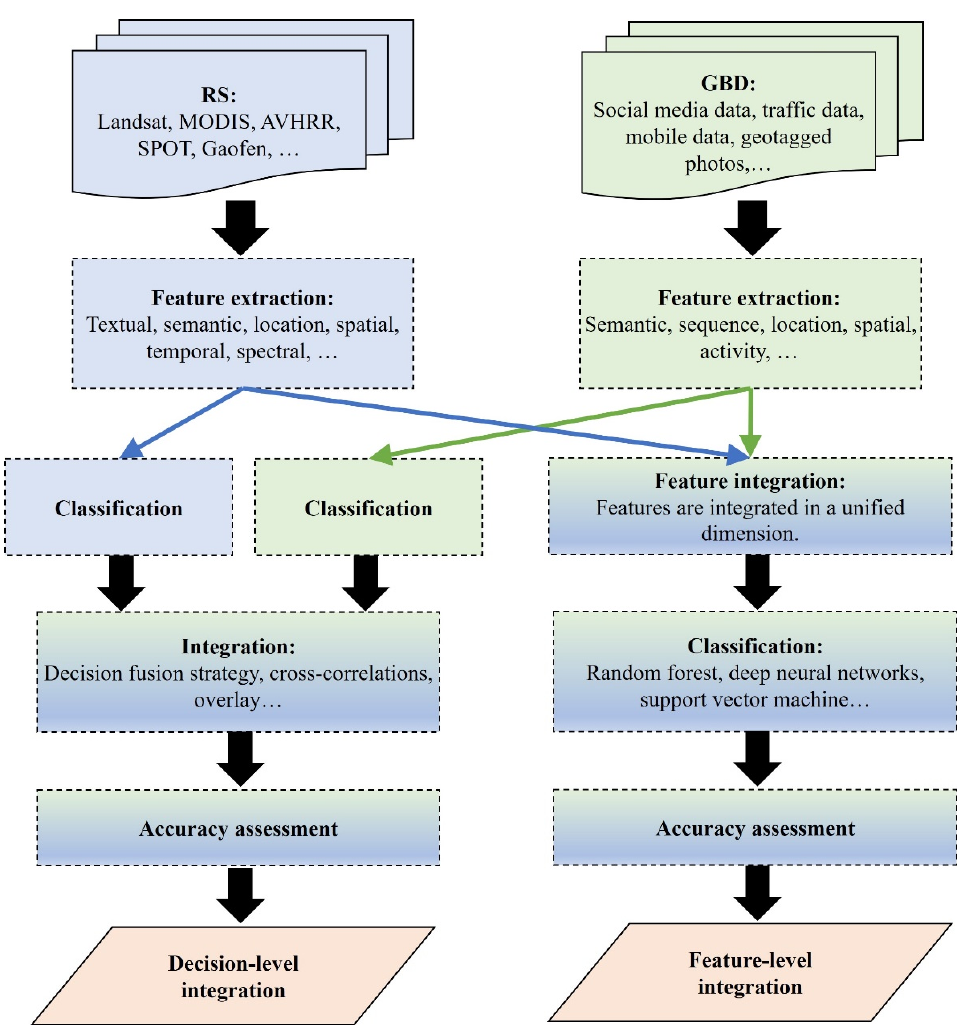
Figure 1. A general framework of the two integration strategies: Decision-level integration (DI), and Feature-level integration (FI).